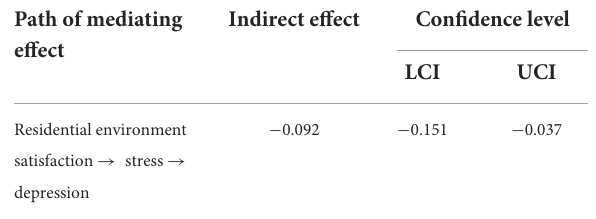
TABLE 6 Bootstrapping analysis